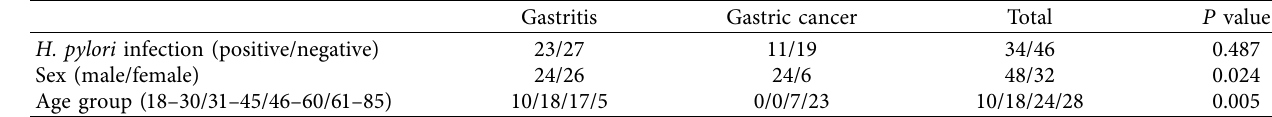
Table 4: Demographic data of patients.